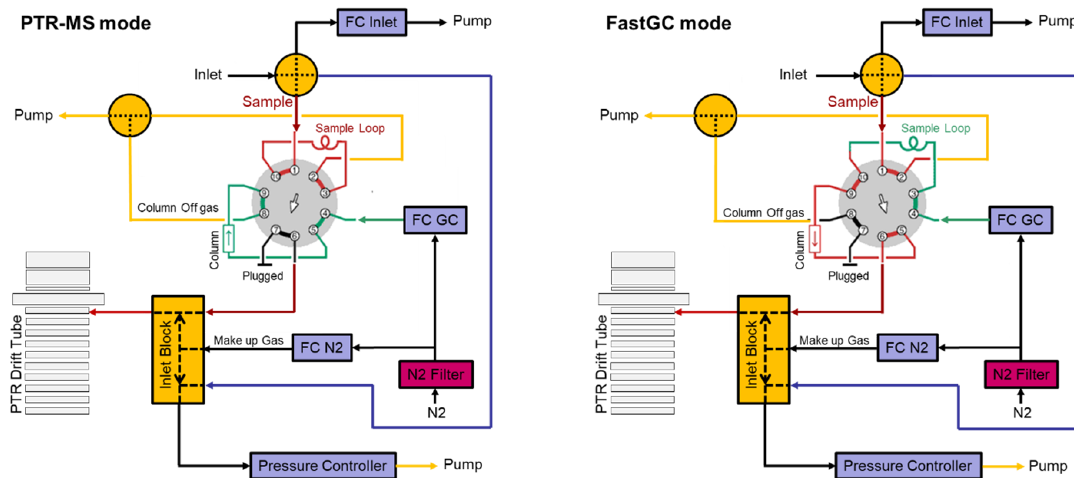
Figure 1. Schematic drawing of a proton transfer reaction-mass spectrometry (PTR-MS) instrument inlet system with a fast gas chromatography (FastGC) setup including a capillary column, a sample loop and a 10-port valve allowing the switching between real-time and FastGC measurements (Source: IONICON, Analytik, Innsbruck). FC: Flow Controller, N2: Nitrogen, GC: Gas